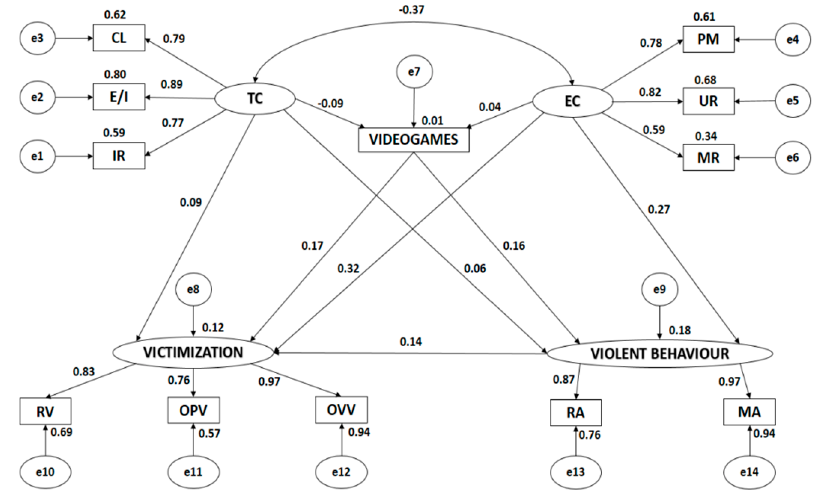
Figure 2. Structural equation model for physical activity. Note: TC, task climate; CL, cooperative learning; E/I, effort/improvement; IR, important role; EC, ego climate; ITR, intra-team rivalry; PM, punishment of mistakes; UR, unequal recognition; VIDEOGAMES, use of videogames; VICTIMISATION, victimisation; RV, relational victimisation; OPV, overt physical victimisation; OVV, overt verbal victimisation; VIOLENT BEHAVIOUR, violent behaviour; MA, manifest aggressiveness; RA, relational aggressiveness. Table 1 . Structural model for physical activity.